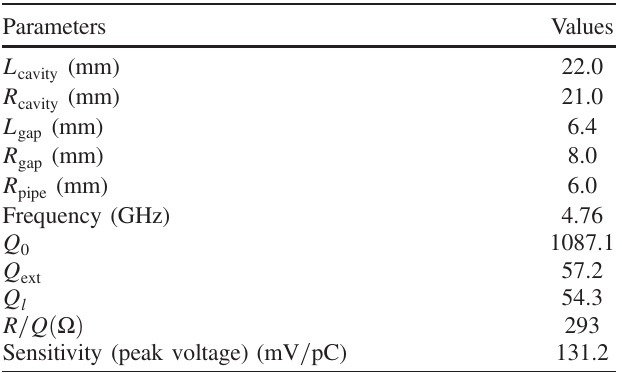
TABLE I. Optimized dimensions and simulation results of the BAM